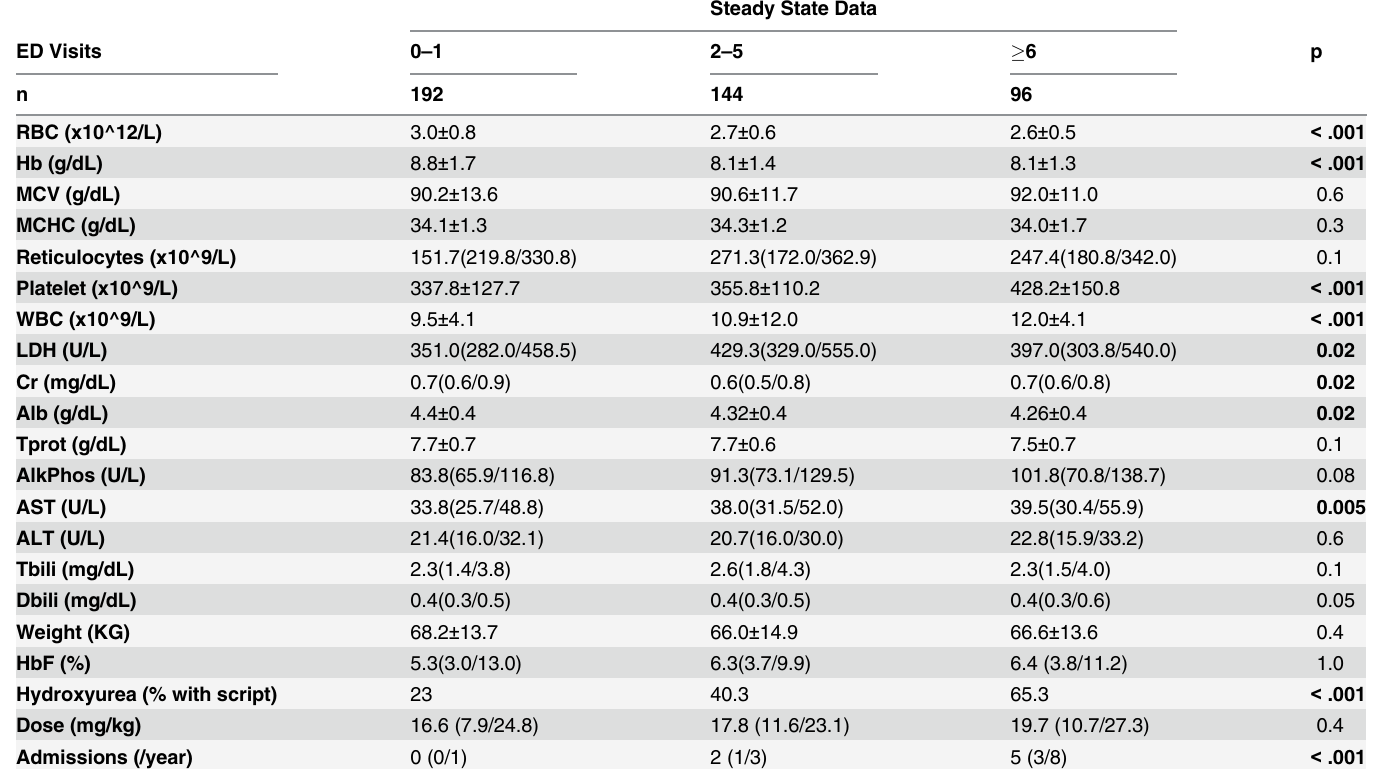
Table 1. Steady state laboratory determinants for each ED utilization cohort. Normalized data reported as means with SDs, non-normalized data reported as medians with 25% and 75%. P values are for ANOVAs done over all 3